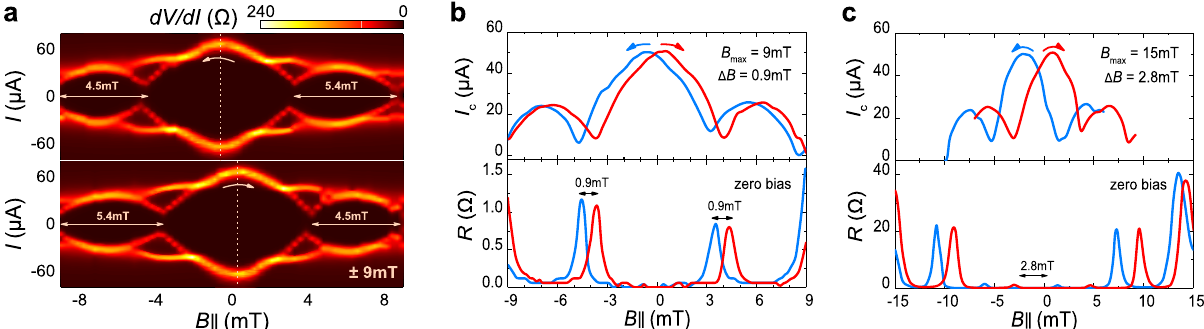
Fig. 2 Hysteretic Fraunhofer patterns of the unsaturated barrier under in-plane magnetic fi eld. a Critical current I c oscillation patterns of device #01 when the magnetic fi eld sweeps from ±9 mT (upper panel: positive to negative; lower panel: inverse). The yellow dashed lines mark out the central maximal of I c , with respect to distinct fi eld positions. b Hysteresis of I c and the corresponding junction resistance R starting from ±9 mT. The effective fi eld seen by the junction has an additional value of 0.9 mT originating from the remnant barrier moment. c Similar hysteresis loop of I c and R for the maximum applied fi eld B fl ux in the junction of 2.8 mT for a magnetic barrier whose magnetization is still max of ±15 mT, which gives a larger contribution to the total